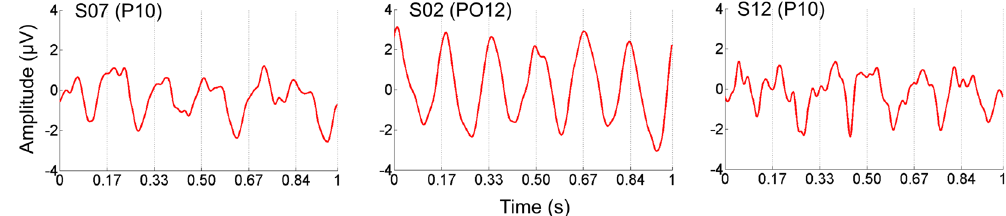
Figure 3. Data from a right occipito-temporal ROI electrode (labeled in parentheses) for three individual participants are shown in the time domain to provide examples of temporal, as well as amplitude, variations in the identity-discrimination response. 0 s represents the onset time of the adapted face sinusoidal cycle onset: adapted faces repeat at 0.33 s and 0.67 s, with unadapted faces presented in between, i.e., at 0.17 s, 0.50 s, and 0.84 s. A somewhat sinusoidal response repeating six times within a second reflects the response to face stimulus presentation at 6 Hz. Asymmetries in the response at 3 Hz, i.e., differences in every other response in magnitude and/or latency, are evidence of differences in the responses to the adapted and unadapted